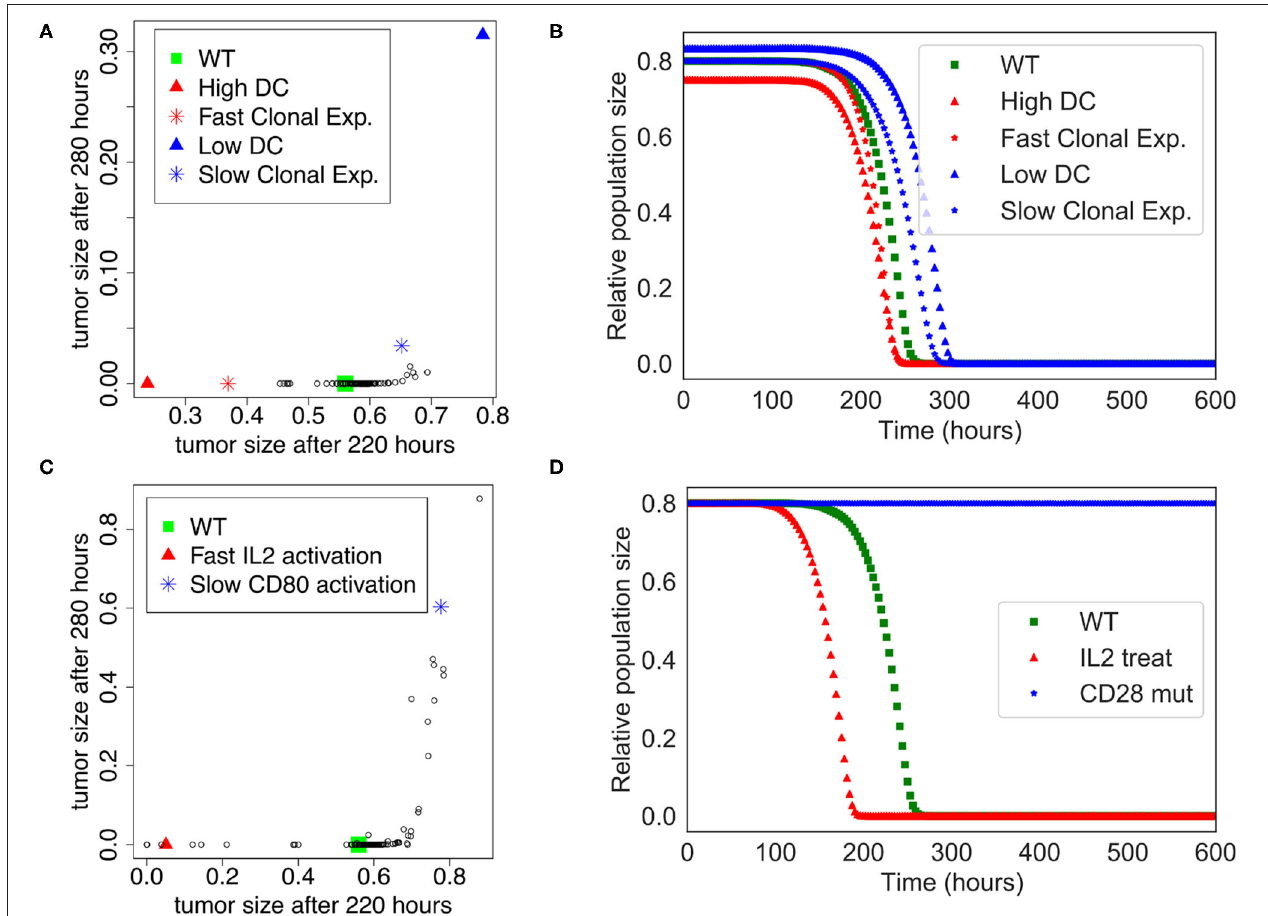
FIGURE 4 | Sensitivity analysis of the Extended Model. (A) Tumor size at time = 220 h vs. time = 280 h when the different parameters of the extended model were increased or decreased by 50 % . Initial amount of Dendritic cells and rate of clonal expansion show the strongest effect (for WT, $ InitDC = 0.1, $ clonal _ exp _ rate = 0.05; for High DC, $ InitDC = 0.15 and Low DC, $ InitDC = 0.067; for Fast Clonal Exp., $ clonal _ exp _ rate = 0.075, and for Slow Clonal Exp., $ clonal _ exp _ rate = 0.033). (B) Kinetics of the size of the tumor cell population according to the parameters changes highlighted in (A) . (C) Tumor size at time = 220 h vs. time = 280 h when the different parameters of the extended model were multiplied or divided by 5. Faster activation of IL2 and slower activation of CD80 have the strongest effect. (D) Kinetics of the size of the tumor cell population following a treatment with IL2 (IL2 treat) or a mutation of CD28 on T cells (CD28 mut), inspired by the parameters changes highlighted in (C)